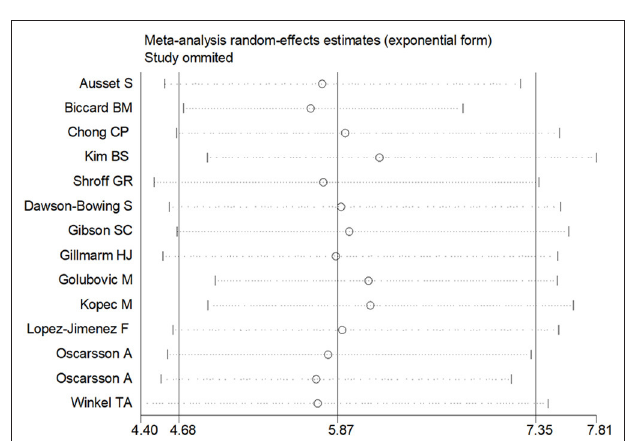
FIGURE 6 | Sensitivity analysis in cTnI and cTnT.